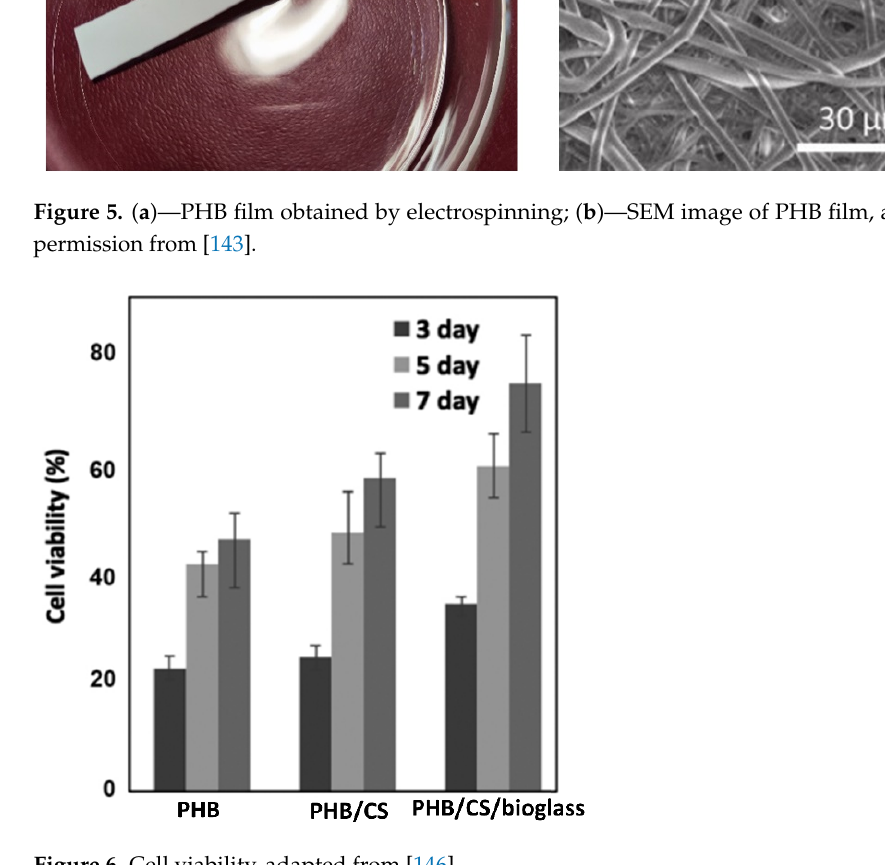
Figure 6. Cell viability, adapted from [146].